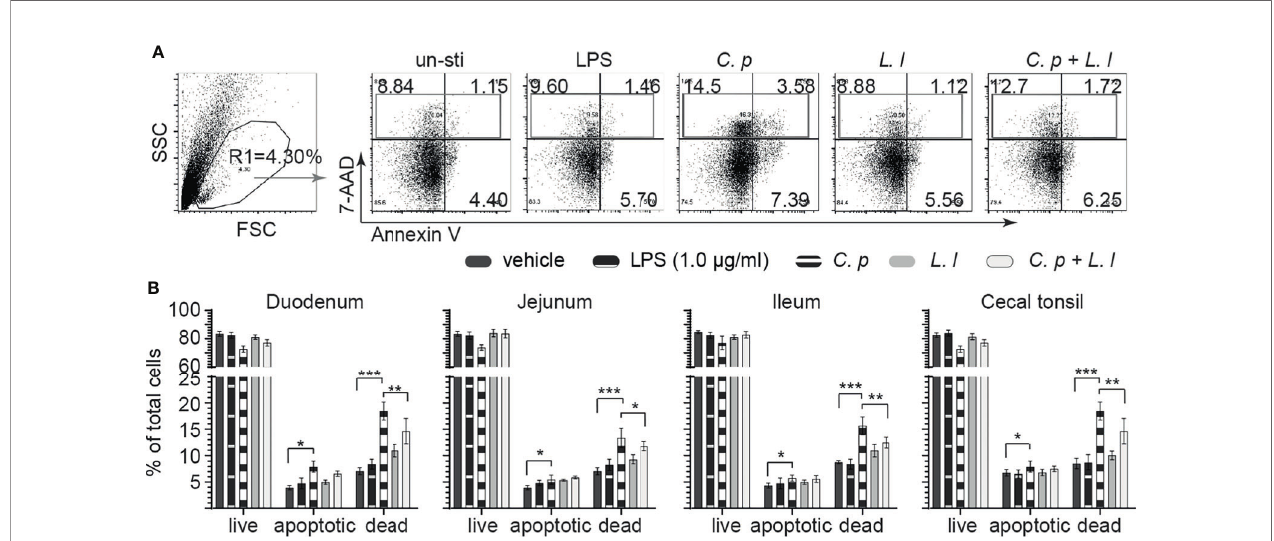
FIGURE 5 | Ex vivo L. lactis treatment improves small intestinal mononuclear cells resistance to C perfringens- induced apoptosis. Small intestine mononuclear cells ( n = 6) isolated from the duodenum, jejunum, ileum, and cecal tonsils were stimulated with medium alone (vehicle), LPS (1 m g/ml), C perfringens (1 MOI), L. lactis (MOI = 1), and combination of C perfringens (MOI = 1) and L. lactis (MOI = 1). Gut mononuclear cells harvested at 18 h poststimulation were stained with 7AAD (dead cell marker) and Annexin V (early apoptotic marker). (A) Dot plots demonstrating the gating strategy utilized to de fi ne live (7AAD-Annexin V-), dead (7AAD +Annexin V+), and apoptotic (7AAD-Annexin V+) mononuclear cells from the (B) duodenum, jejunum, ileum, and cecal tonsil. Paired t -test was used to assess normal distribution and test signi fi cance. * p < 0.05, ** p < 0.001, and *** p < 0.0005 indicate a statistically signi fi cant difference. The mean ± SD value are shown from three independent experiments performed in